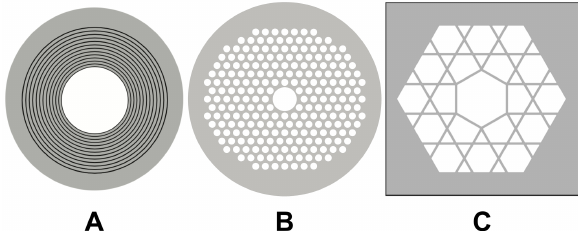
Fig. 2. Cross-section of (A) Bragg fiber (Source: [12]) (B) HCPC fiber (C) Kagome fiber. (Source: